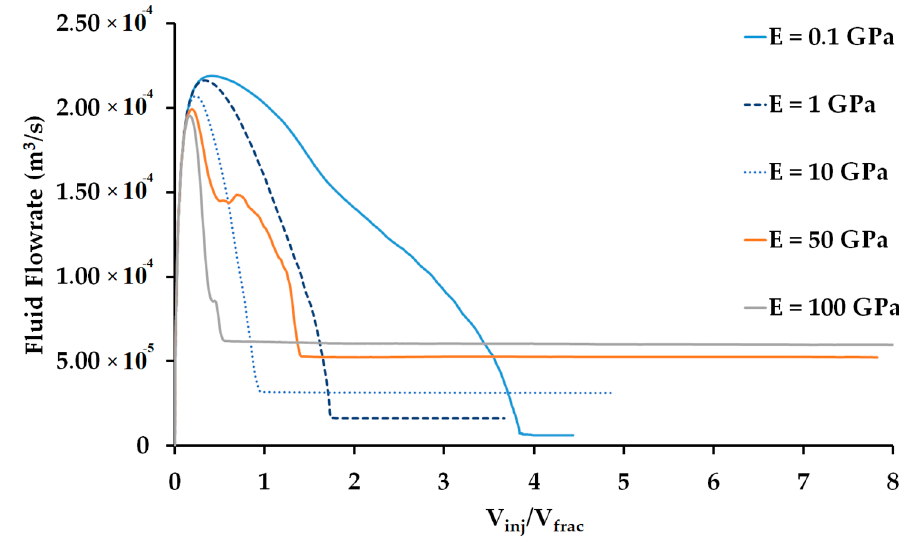
Figure 10. Flowrate at the fracture outlet from cases with various Young’s moduli.